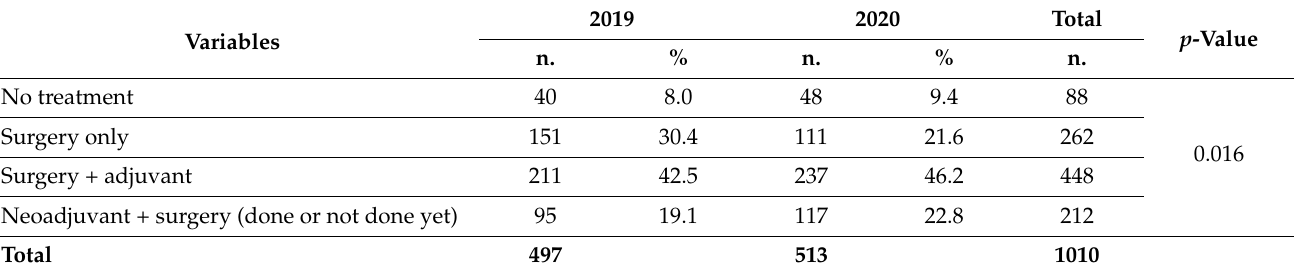
Table 3. Distribution of cases by treatments, surgery and chemotherapy and year of diagnosis.